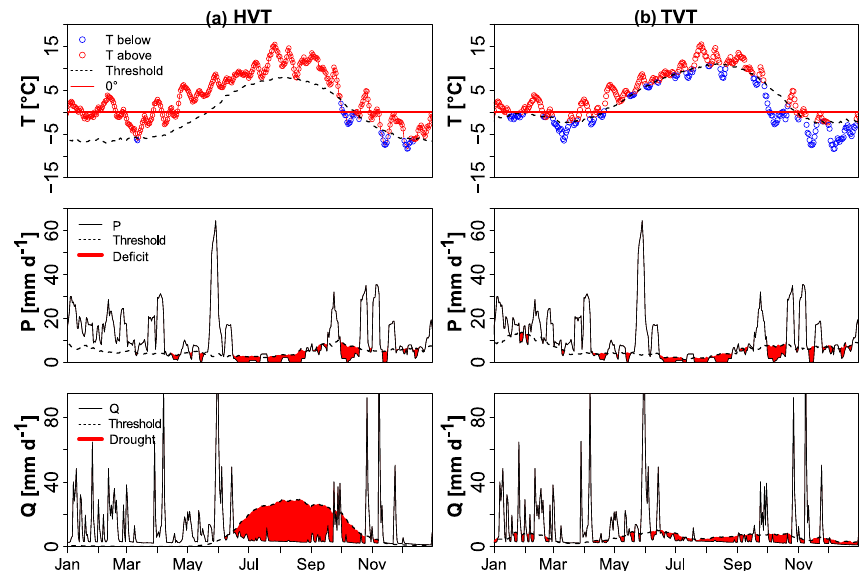
Figure 10. Example of streamflow drought and causing factors ( T and P ) for the different threshold methods. Panel (a) shows the HVT and (b) the TVT. Temperature, precipitation and discharge time series are presented for the Wolverine catchment for 2091 based on climate scenario RCP4.5 and the dynamic glacier area conceptualisation. For the P and T time series, a 7-day moving average was